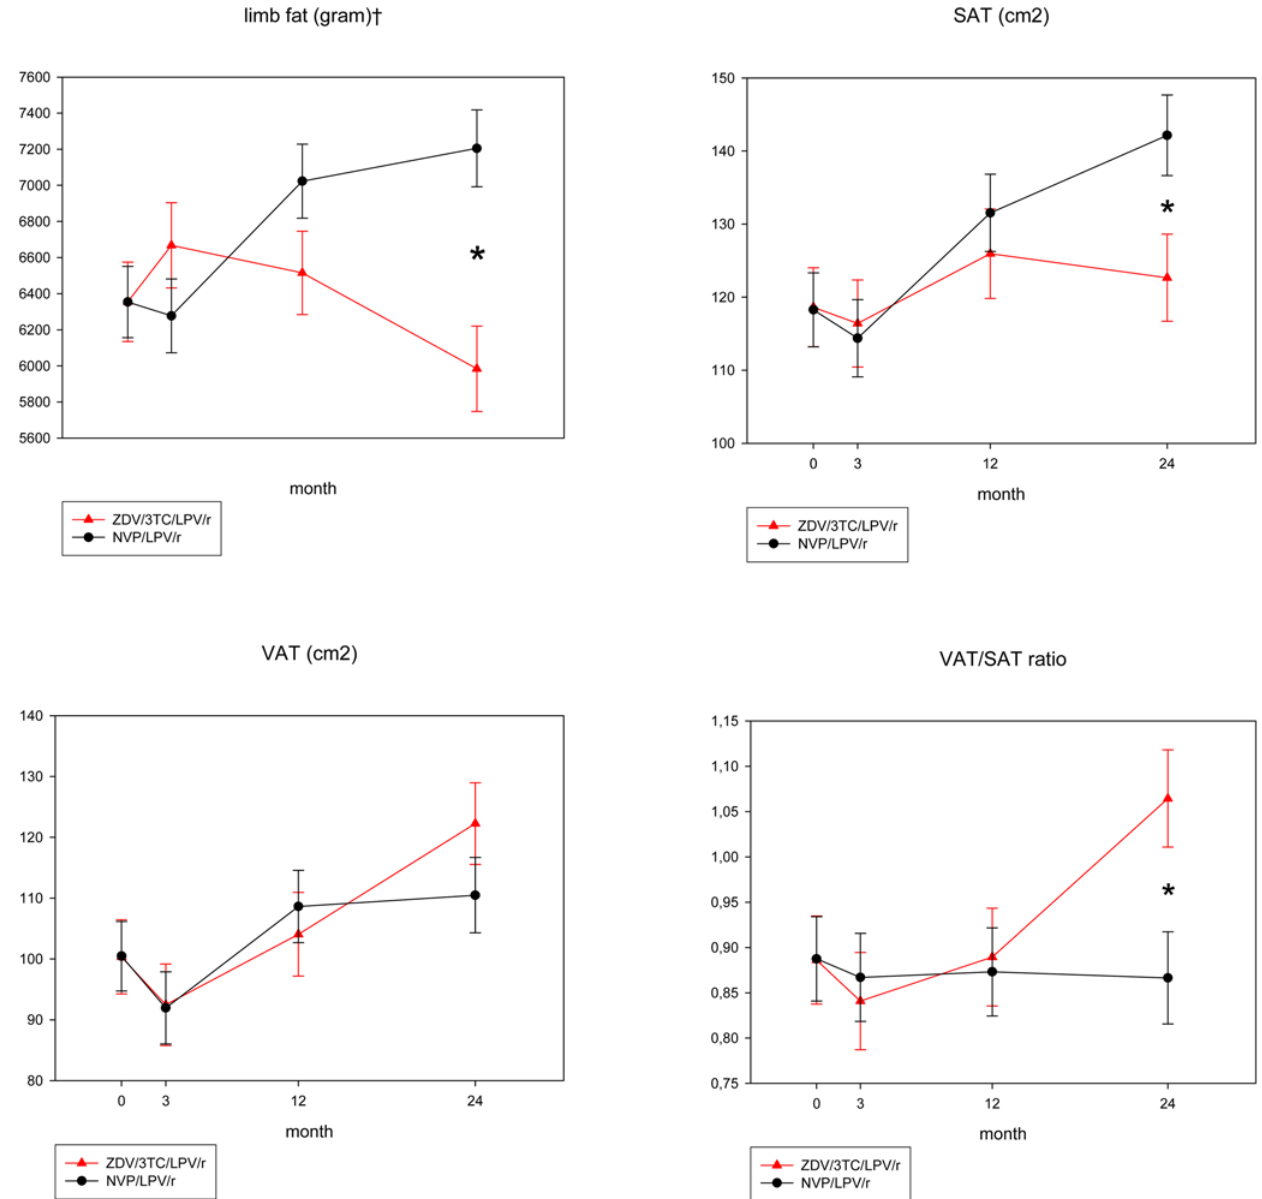
Figure 2. Body composition by Dexa and CT. Shown are estimated means 6 standard error of the mean (mixed model repeated measures analysis with correction for differences in baseline values). ZDV/3TC/LPV/r zidovudine/lamivudine/lopinavir/ritonavir. NVP/LPV/r nevirapine/lopinavir/ ritonavir. *p , 0.05 between groups at visit. { p , 0.05 overall difference between groups.